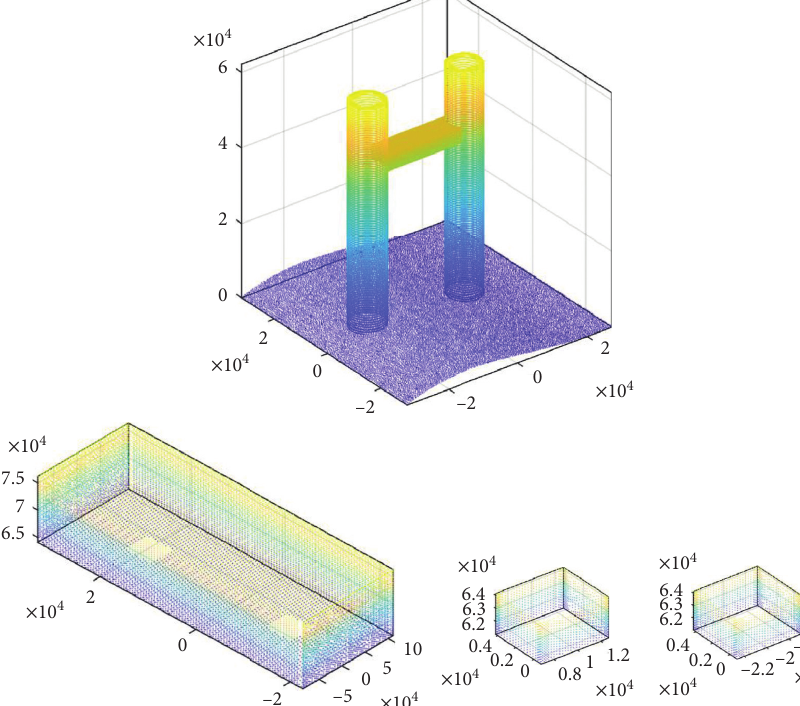
Figure 7: Nonflat ground point cloud after the first